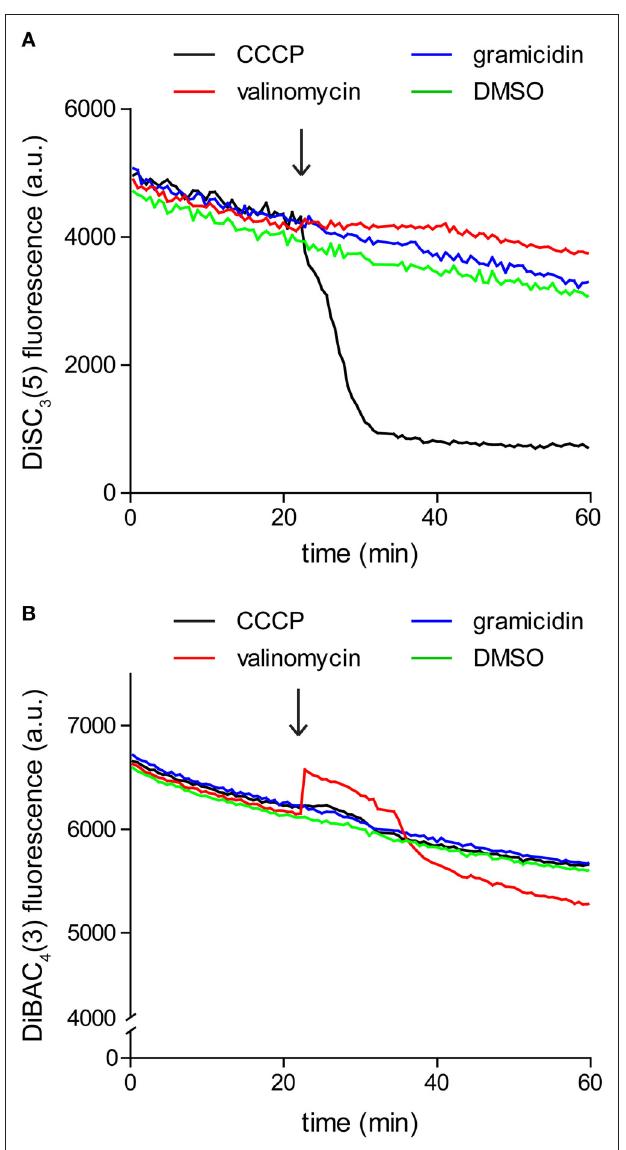
FIGURE 3 | Interference between dye fluorescence and ionophores. (A) Fluorescence intensity of 1 µ M DiSC 3 (5) in LB medium upon addition of channel-forming peptide gramicidin (1 µ M), K + carrier depsipeptide valinomycin (5 µ M), and a non-peptide protonophore CCCP (30 µ M). The time point of addition is highlighted with an arrow. Note the gradual decay of fluorescence signal due to binding on the polystyrene-surface of the microtiter plate, and the strong reduction of fluorescence upon addition of CCCP, which disqualifies the use of CCCP in combination with DiSC 3 (5). (B) Fluorescence intensity of 10 µ M DiBAC 4 (3) in LB medium upon addition of channel forming peptide gramicidin (1 µ M), K + carrier depsipeptide valinomycin (5 µ M), and the non-peptide protonophore CCCP (30 µ M). In case of this dye, interference is observed with valinomycin.